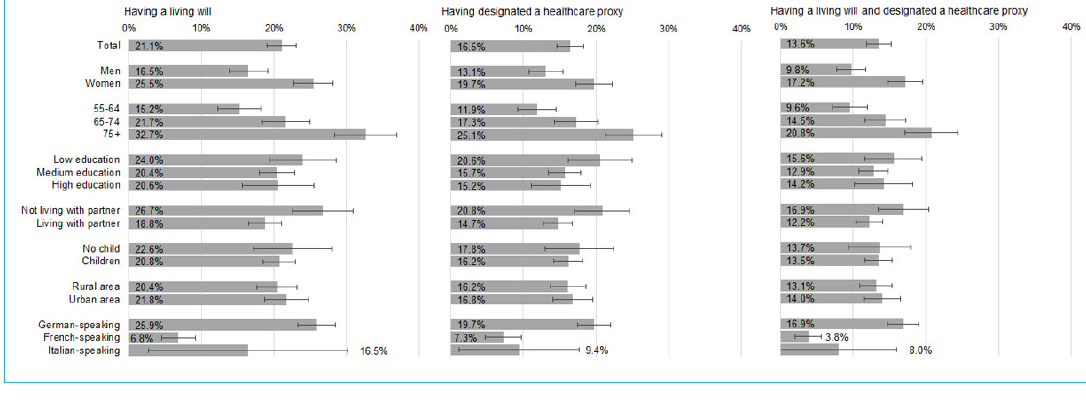
Figure 2: Awareness, approval and completion of advance directives (ADs) by sociodemographic characteristics, adults aged 55+ in Switzer- land, weighted percentage and 95% confidence intervals, SHARE